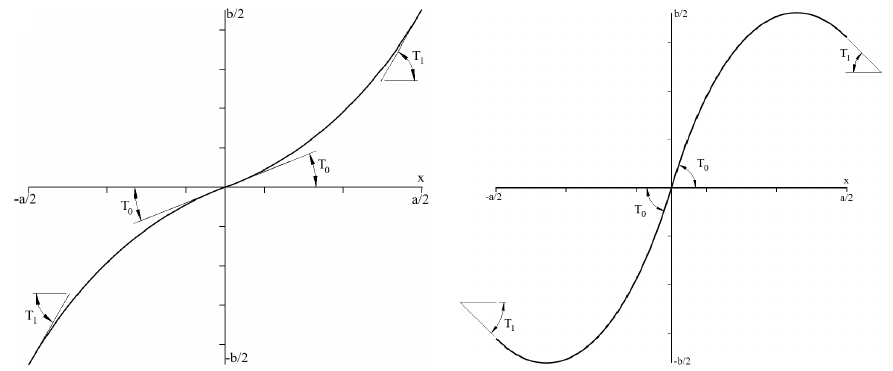
Figure 1. Fiber Path for 〈 20|60 〉 configuration ( left ) and 〈 50| − 20 〉 configuration ( right ). Figure 1. Fiber Path for (cid:104) 20 | 60 (cid:105) configuration ( left ) and (cid:104) 50 | − 20 (cid:105) configuration ( right ).